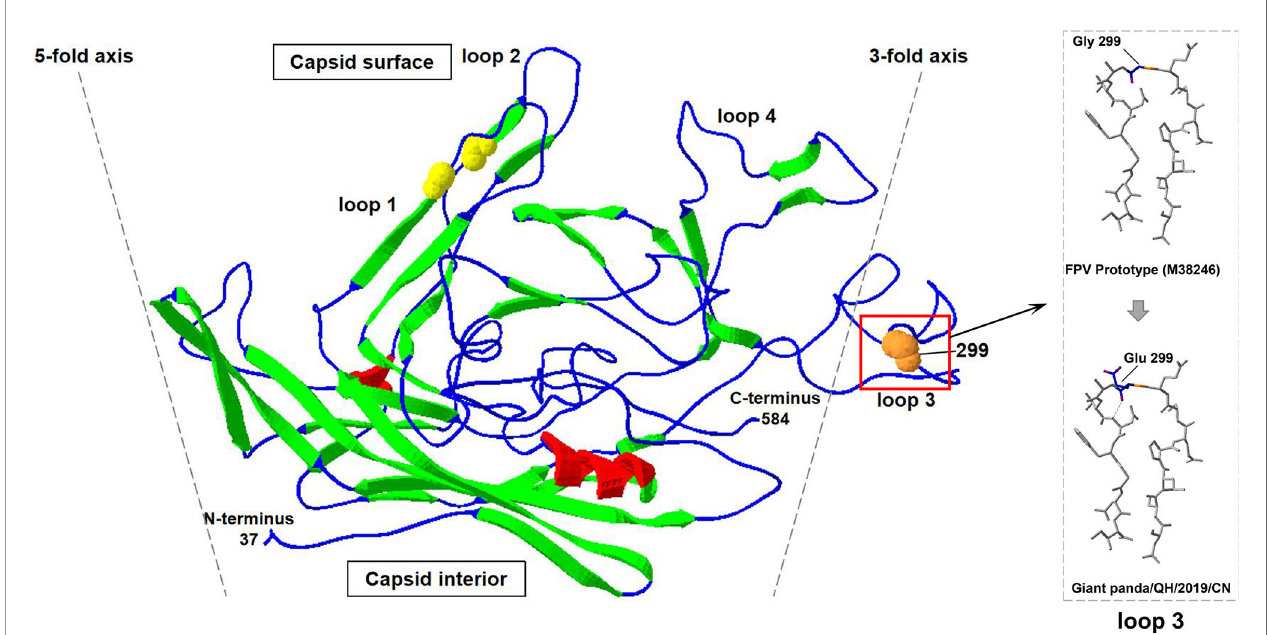
FIGURE 3 | The cartoon ribbon diagram of a VP2 capsid monomer of FPV (PDB ID: 1FPV) when viewed tangentially to the surface of the virus. The b -strands, a -helix, and interconnecting surface loop are indicated by green, red, and blue. Spheres show the positions of the natural (orange) mutations of the isolate Giant panda/CD/2018. Loop 3 that contained amino acid mutation is labeled via black boxes, and is magni fi ed in dotted